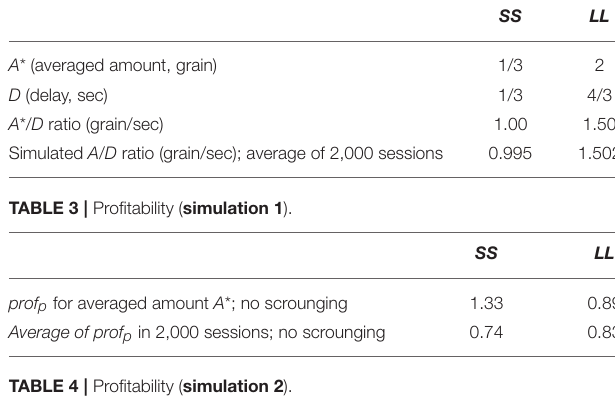
TABLE 2 | Amount, delay, and A / D ratio ( simulation 2 ).